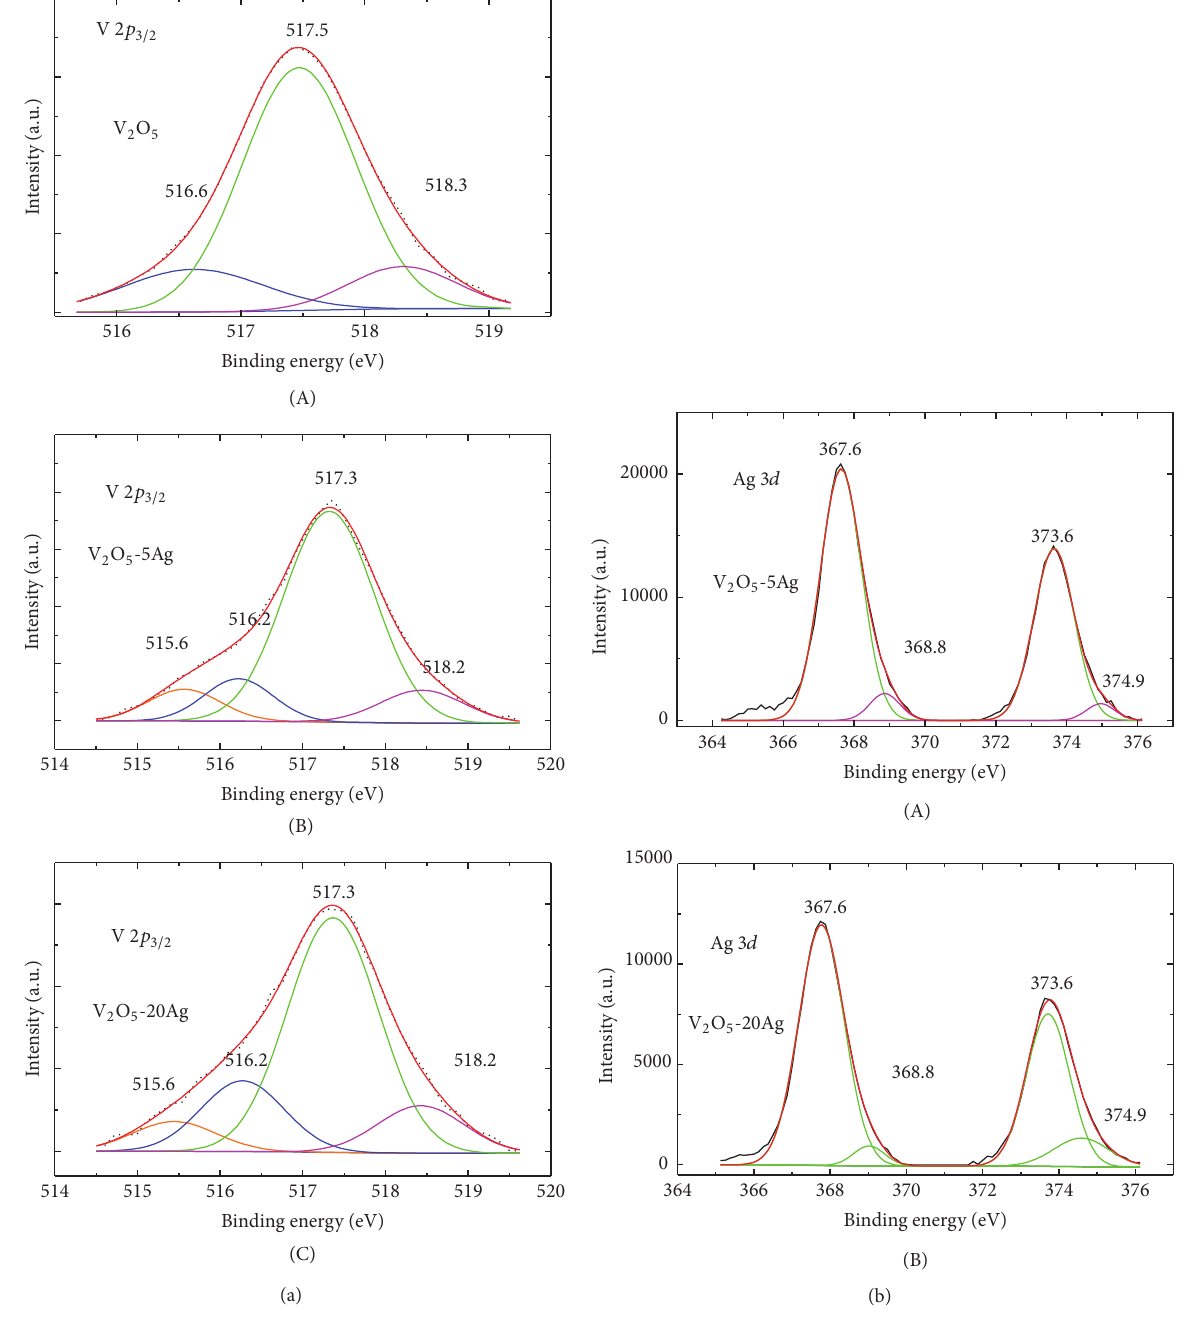
Figure 9: Core level spectra of (a) V 2𝑝 3/2 of (A) V 2 O 5 , (B) V 2 O 5 -5Ag, and (C) V 2 O 5 -20Ag and of (b) Ag 3𝑑 5/2 for (A) V 2 O 5 -5Ag and (B) V 2 O 5